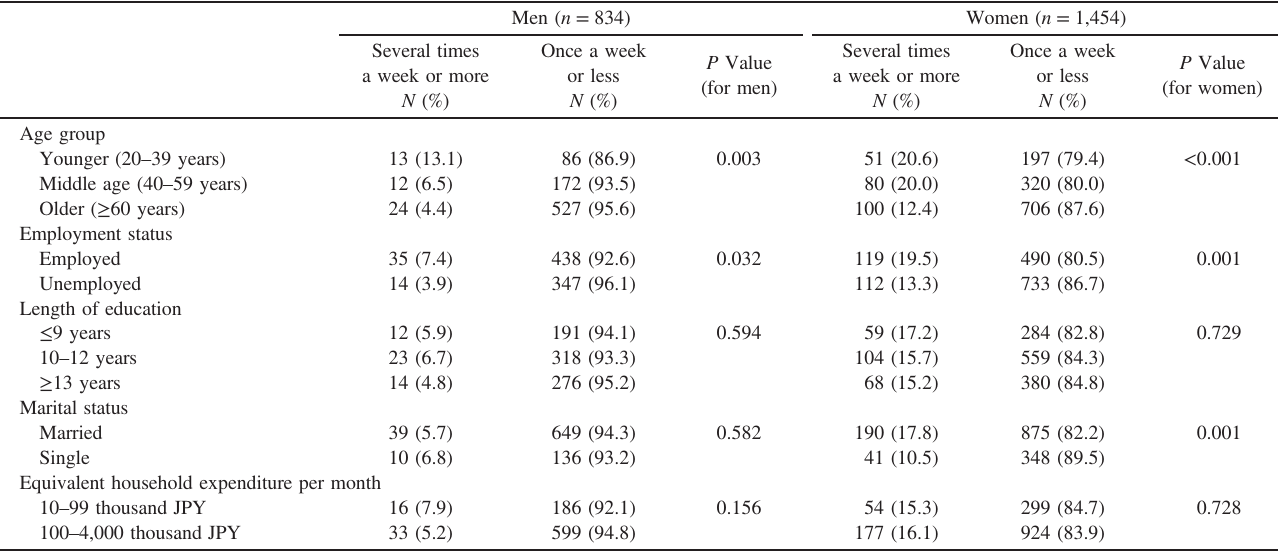
Table 2. Characteristics of passive smoking at home by socioeconomic status and gender, NIPPON DATA2010 ( n = 2,288) Men ( n = 834) Women ( n =